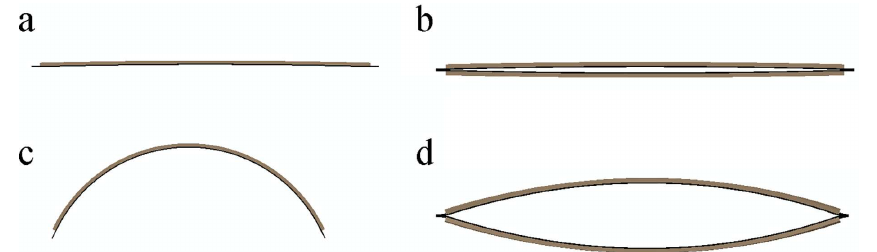
Fig 8. Finite element simulation of bilayer and bilayer cell. Left: single bilayer in initial (a) and actuated state (c); Right: Bilayer-cell in initial (b) and actuated (d)